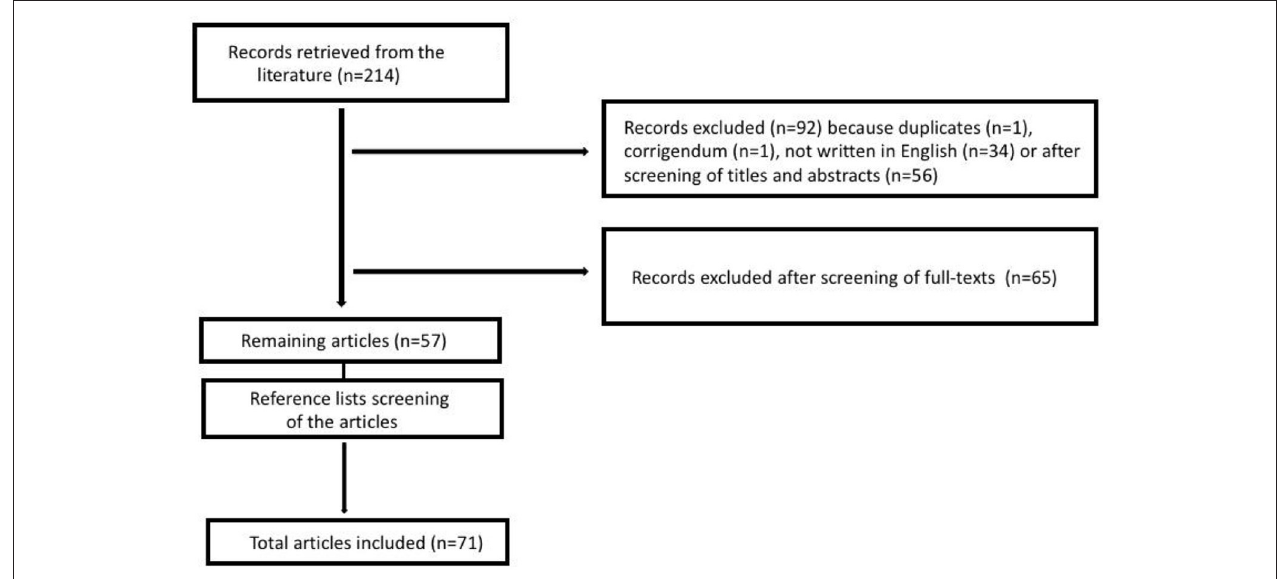
FIGURE 1 | Flowchart of the research